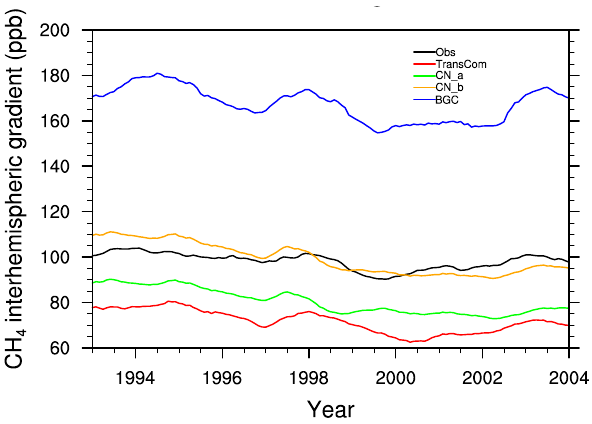
Figure 10. The interhemispheric gradients (N–S) in atmospheric CH 4 concentration. The N–S gradients are calculated as the differ- ence in atmospheric CH 4 concentration in Northern and Southern hemispheres at these stations listed in Table 1. The observational CH 4 concentration data set at these stations is from the World Data Centre for Greenhouse Gases (WDCGG) at http://ds.data.jma.go.jp/